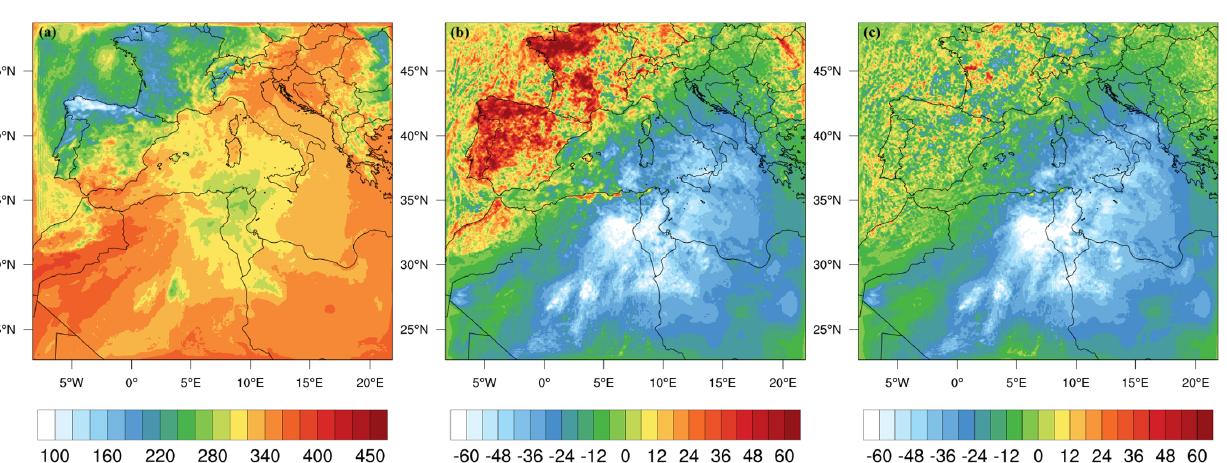
Figure 11. Simulated surface shortwave downwelling flux (SSWDN) anomalies; ( a ) FULL − CTL runs difference; ( b ) MP − CTL runs difference and ( c ) RAD − CTL runs difference. Units are W m − 2 .